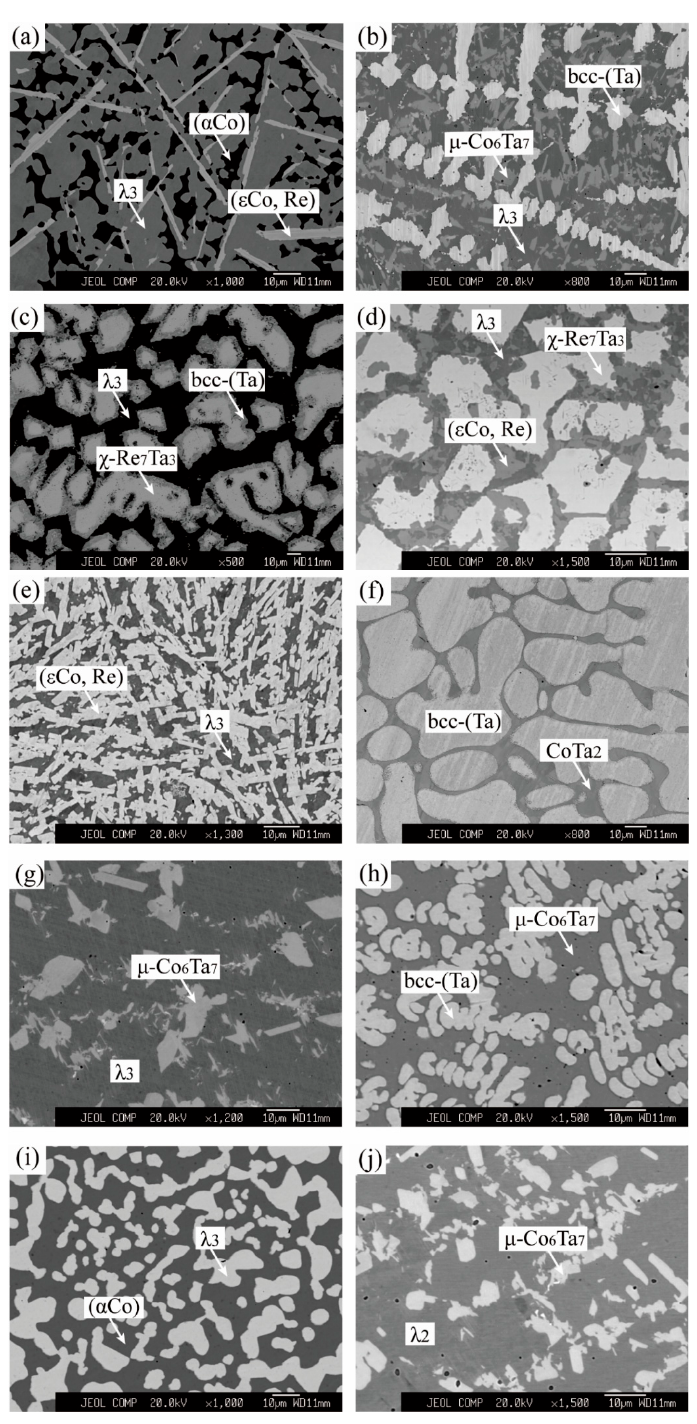
Figure 2. Back-scattered electron (BSE) images of the typical ternary Co-Re-Ta alloys: ( a ) The Co 74 Re 16 Ta 10 alloy annealed at 1100 ◦ C for 50 days; ( b ) the Co 44 Re 14 Ta 42 alloy annealed at 1200 ◦ C for 35 days; ( c ) the Co ◦ C for 25 days; ( d ) the Co 31 Re 35 Ta 34 alloy annealed at 1300 45 Re 30 Ta 25 alloy annealed at 1300 ◦ C for 25 days; ( e ) the Co 54 Re 25 Ta 21 alloy annealed at 1100 ◦ C for 65 days; ( f ) the Co 22 Re 5 Ta 73 alloy annealed at 1100 ◦ C for 50 days; ( g ) the Co 58 Re 3 Ta 39 alloy annealed at 1200 ◦ C for 35 days; ( h ) the Co 25 Re 20 Ta 55 alloy annealed at 1200 ◦ C for 50 days; ( i ) the Co 80 Re 11 Ta 9 alloy annealed at 1300 ◦ C for 15 days; ( j ) the Co 60 Re 1 Ta 39 alloy annealed at 1300 ◦ C for 15